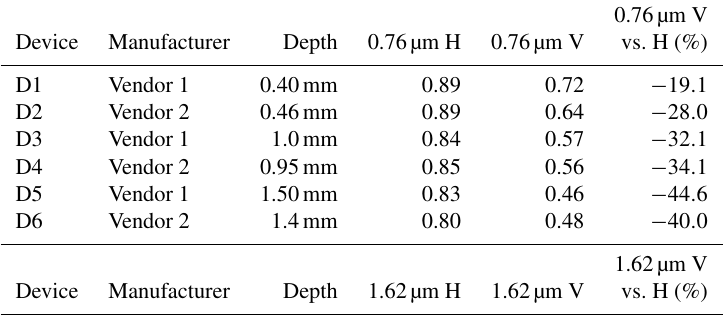
Table 2. Throughput as compared to a thin slit for different devices with an F number of f/ 4 . 5 for horizontal (H) and vertical (V)